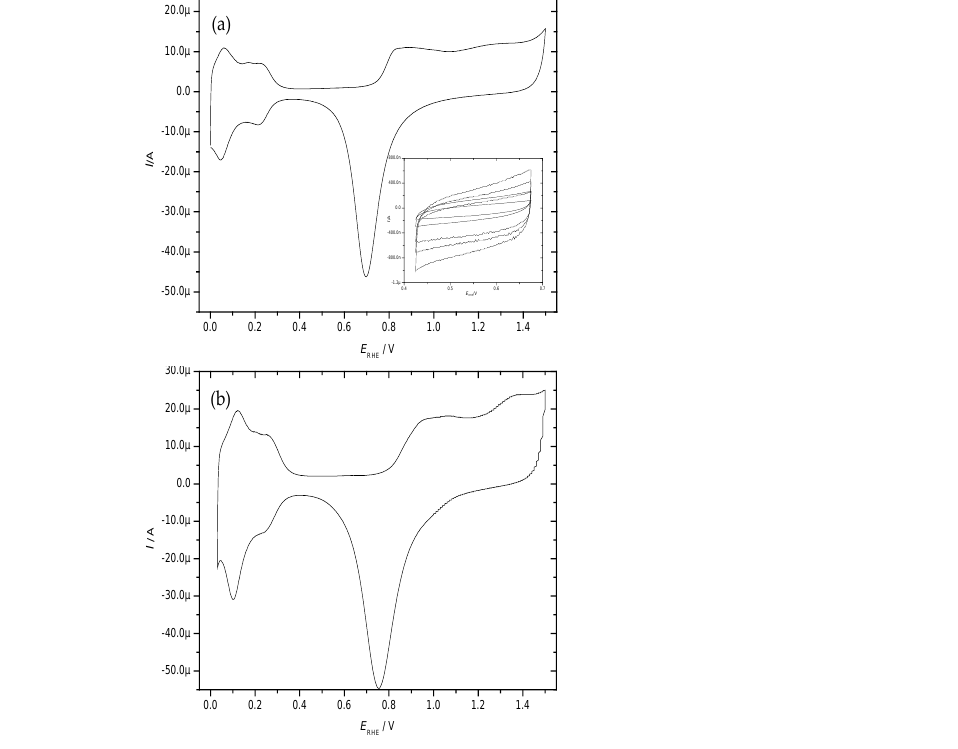
Figure 3. Nyquist and Bode plots of the platinum disc electrode (with 9.9 mC platinum deposit) in contact with an aqueous electrolyte solution of 0.1 M (NH 4 ) 2 Fe(SO 4 ) 2 + 0.1 M (NH 4 )Fe(SO 4 ) 2 + 1 M HClO 4 .